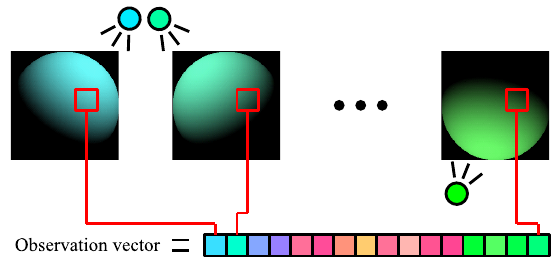
Figure 3. Observation